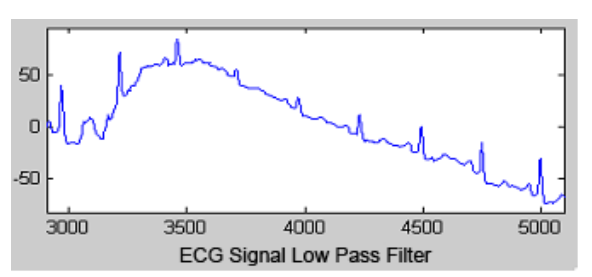
Figure 3. Low pass filtered signal.